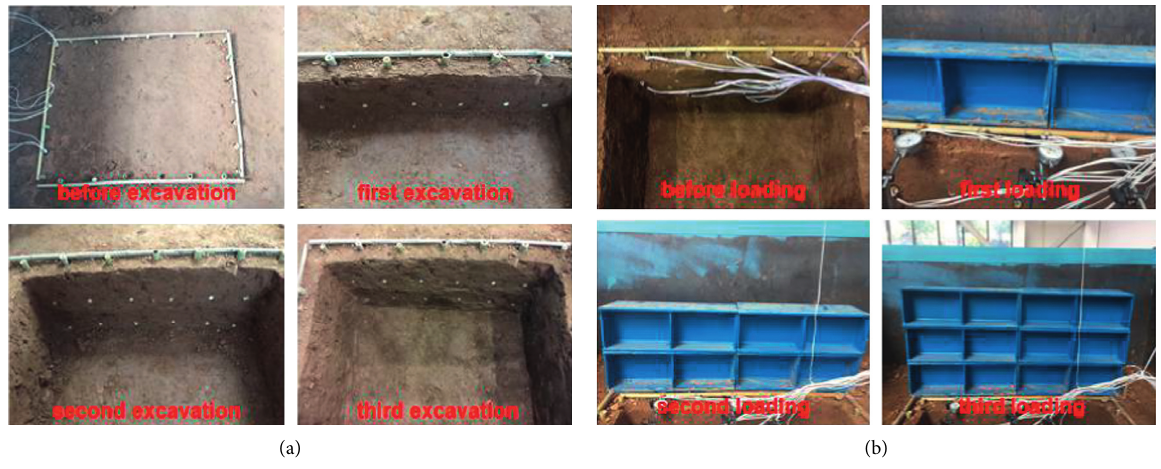
Figure 4: (a) Excavation and (b) loading of foundation pit.